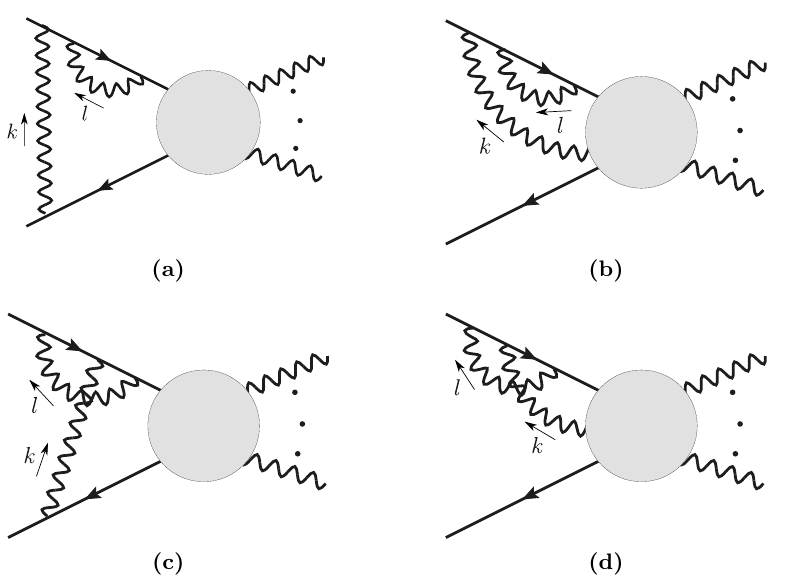
Figure 12. Diagrams requiring special treatment. We refer to the diagrams of the first line as type S, and of the second line as type